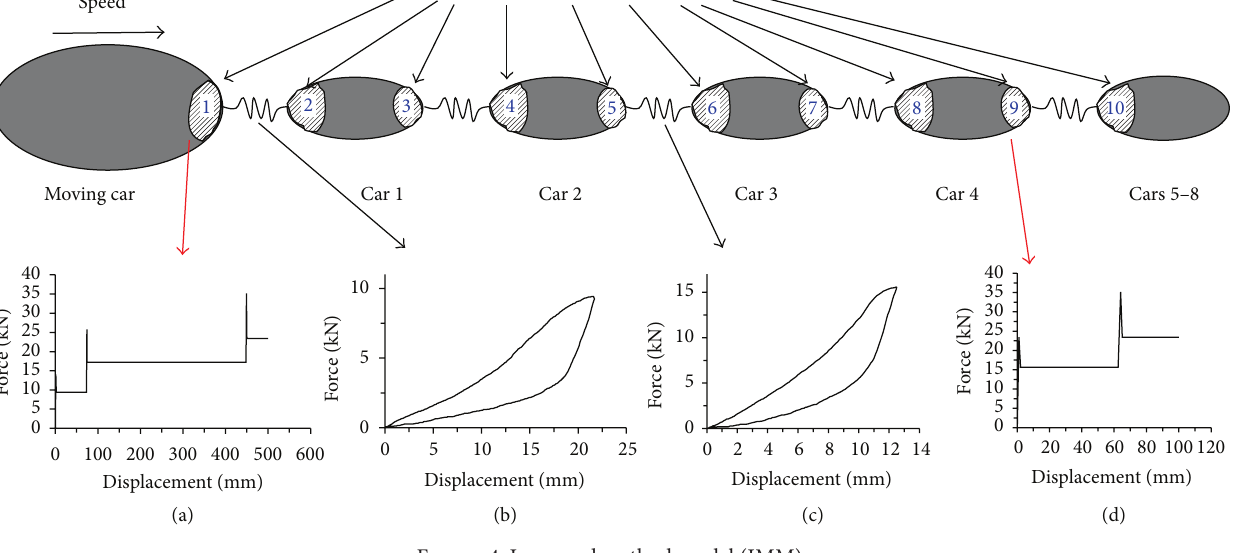
Figure 4: Improved method model (IMM).